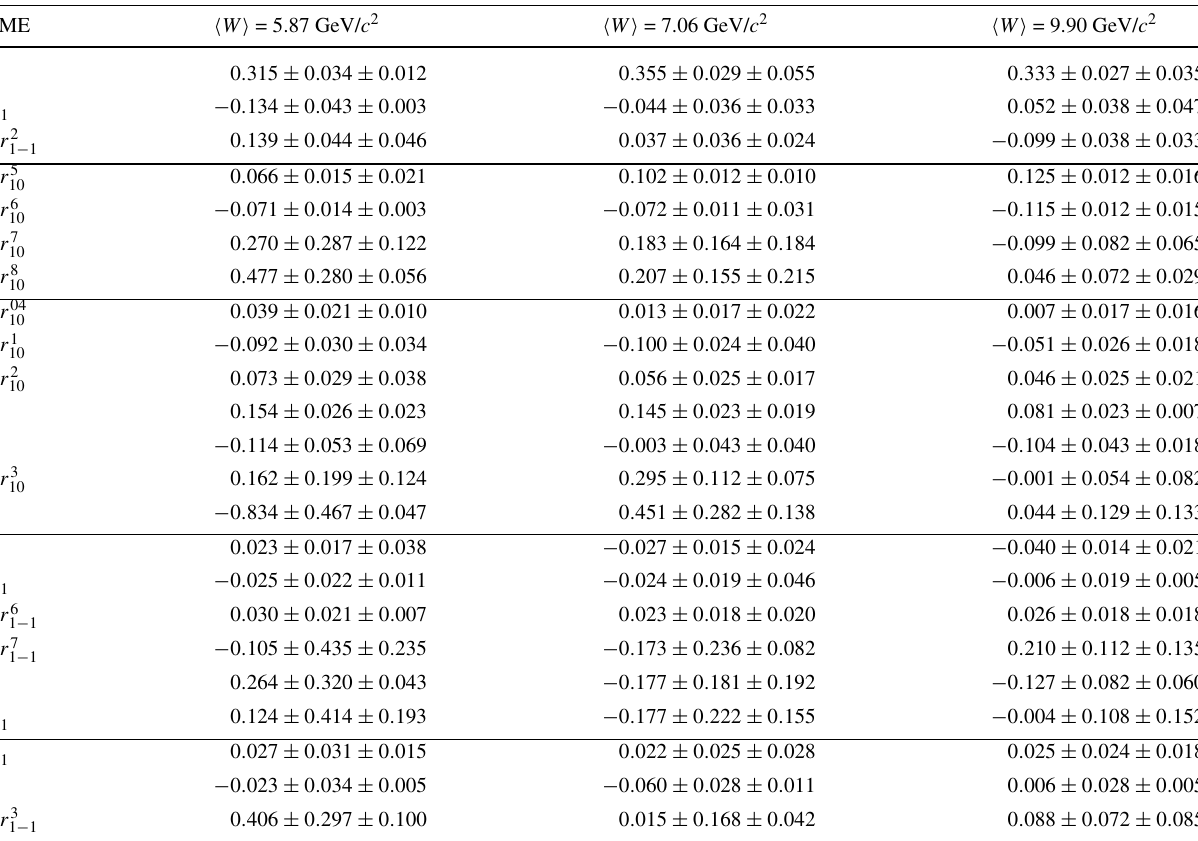
Table 7 The measured 23 unpolarised and polarised ω SDMEs in bins of W : 5 . 00 − 6 . 4 − 7 . 9 − 17 . 0 GeV/ c 2 . The first uncertainties are statistical, the second